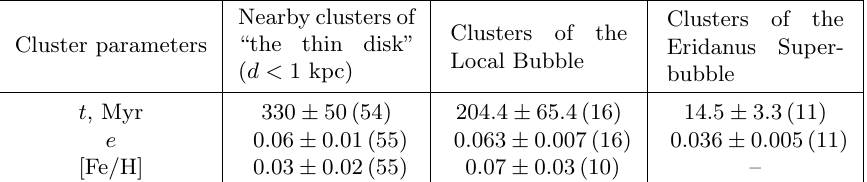
Table 1. Characteristic parameters of the open clusters. Cluster parameters